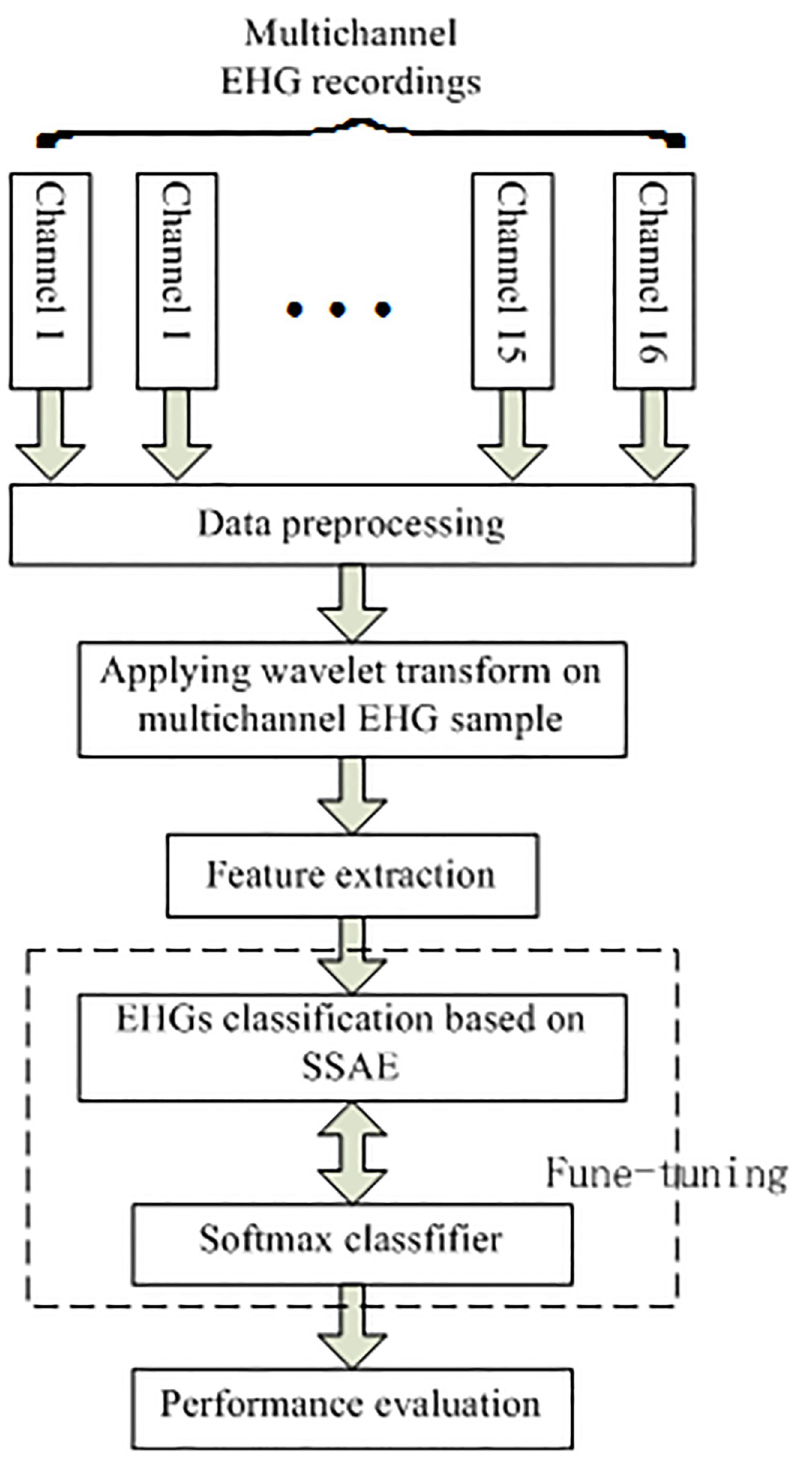
Fig 1. The generalized block diagram of the proposed